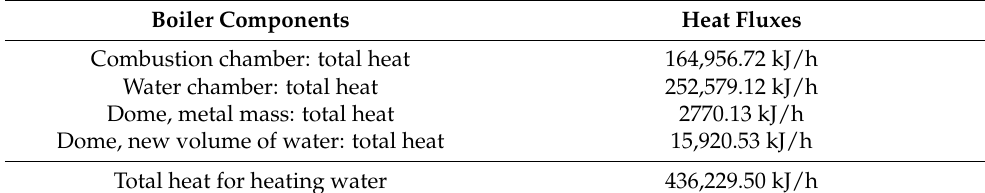
Table 4. Theoretical heat fluxes to obtain hot